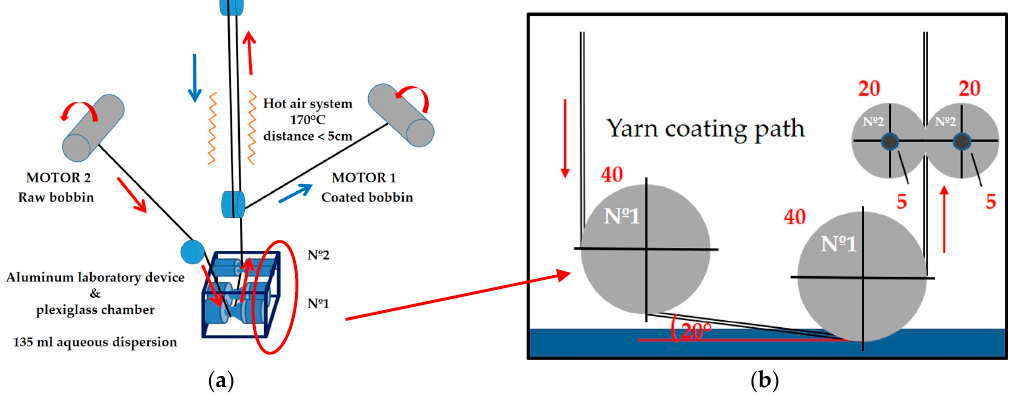
Figure A1. Roll to roll coating—scheme: ( a ) process, ( b ) aluminum laboratory device—lateral side.